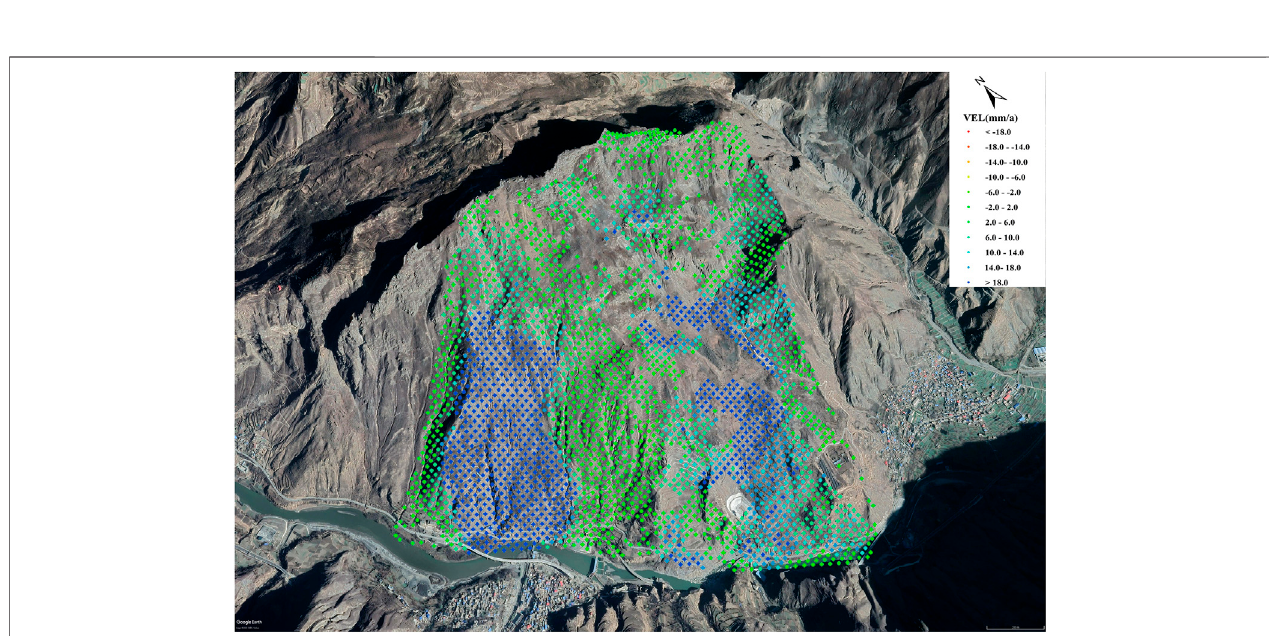
FIGURE 9 | Deformation from the descending orbit data.